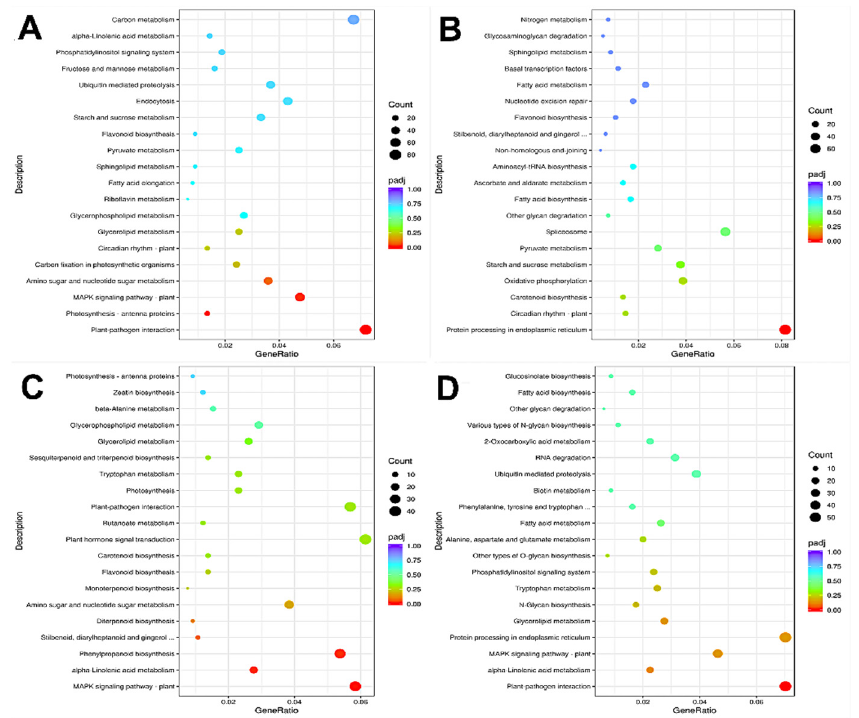
Figure 6. KEGG enrichment analysis of differentially expressed genes. Annotation: ( A ) A2 compared to A1; ( B ) B2 compared to B1; ( C ) A1 compared to B1; ( D ) A2 compared to B2. The horizontal coordinate in the figure is the ratio of the number of different genes and the total number of genes annotated to KEGG pathway. The ordinate is KEGG pathway, the size of the point represents the number of genes annotated to KEGG pathway, red represents the significant enrichment, and purple represents the small enrichment significance.